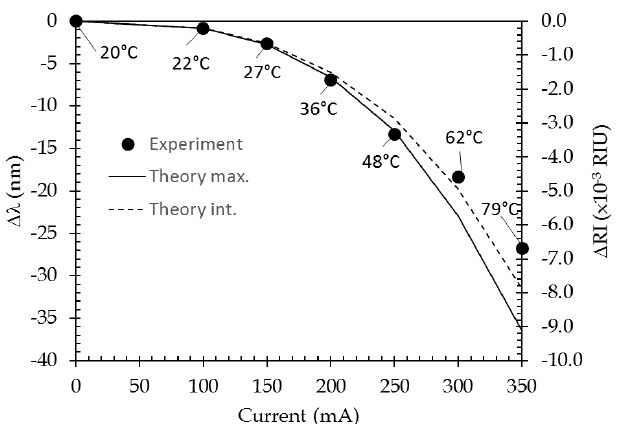
Table 3. Driving currents, corresponding temperature rises, and water refractive indices.